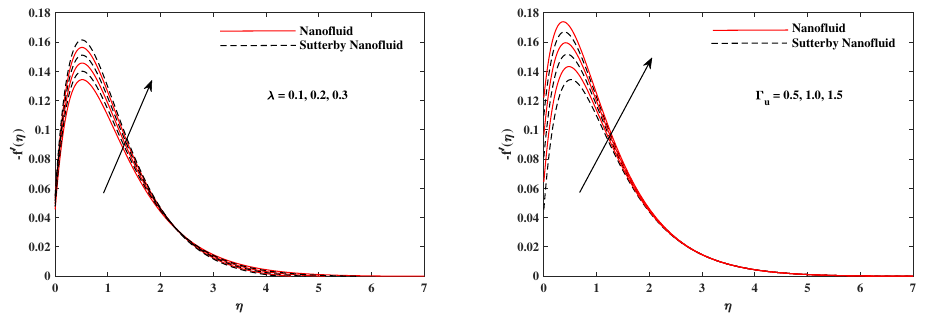
Figure 4. f (cid:48) ( η ) fluctuate in x-direction with λ and Γ u .